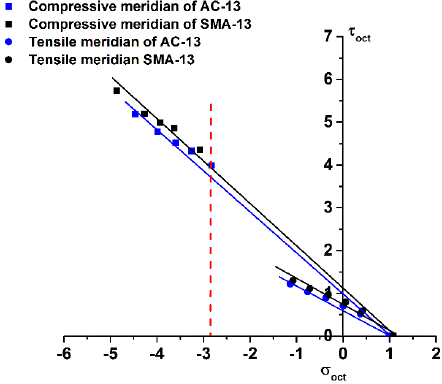
Figure 11. Linear tensile and compressive meridians. Table 6. Parameters of the linear failure criteria.